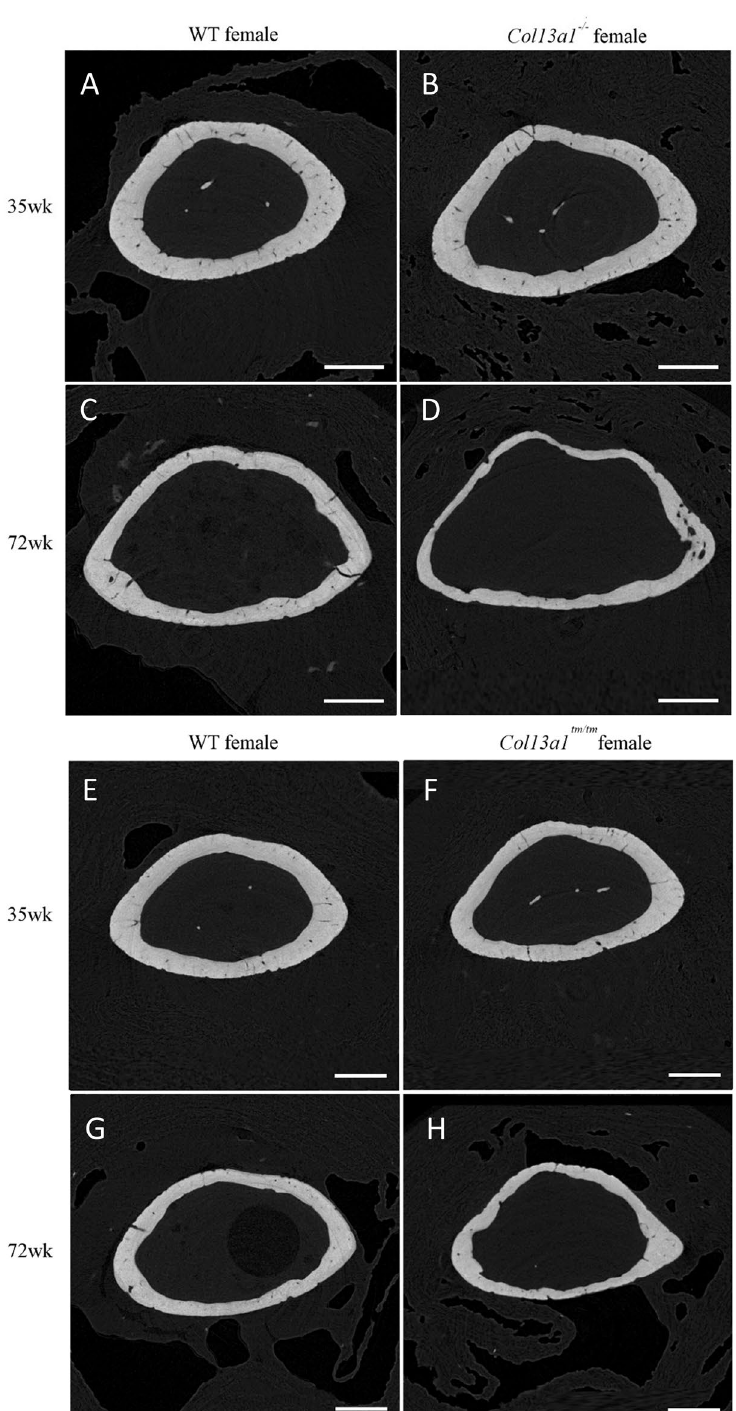
Figure 5. Single scaled axial tomographic µCT images of distal metaphyseal femoral cortical bone in female Col13a1 −/− , Col13a1 tm/tm and WT control mice at the age of 35 and 72 weeks. Whereas bone morphology was similar at the 35-week time point ( A , B ), cortical bone mass was clearly reduced in the Col13a1 −/− mice at the 72-week time point compared to the WT samples ( C , D ). The metaphyseal cortical bone mass was significantly reduced in the Col13a1 tm/tm mice at both time points compared to the WT controls ( E – H ). Scale bars 500